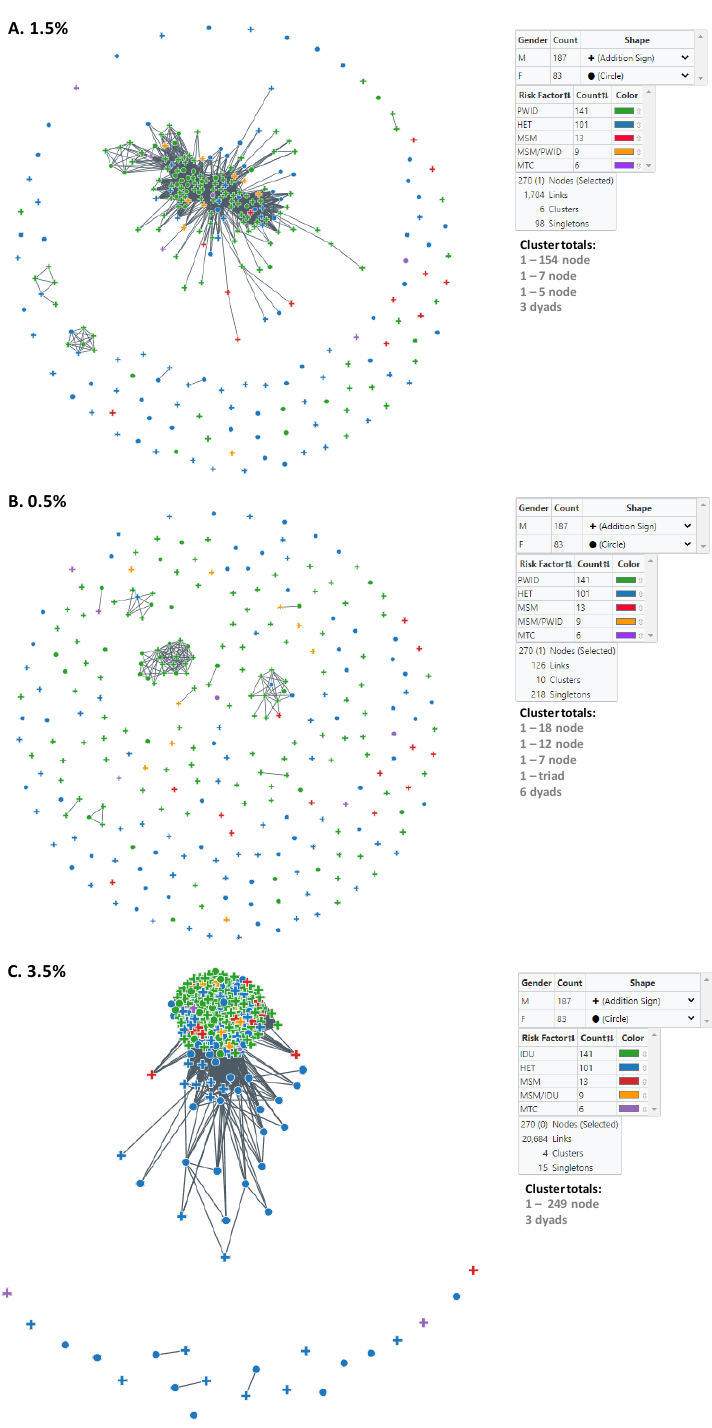
Figure 2. Inference of subtype CRF01-AE clusters in Bulgaria using MicrobeTrace. ( A ) Six clusters were identified using a genetic distance ( d ) of 1.5% compared to ( B ) ten clusters at d = 0.5%. Sex is indicated by circles (male) and addition sign (female). ( C ) Transmission network at d = 3.5%. Transmission category is indicated with color (red, men who have sex with men (MSM); green, persons who inject drugs (PWID); blue, heterosexual (HET); gold, persons reporting both MSM and PWID; purple, mother-to-child (MTC). Cluster totals by node (members) and total number of links in the transmission network is provided.